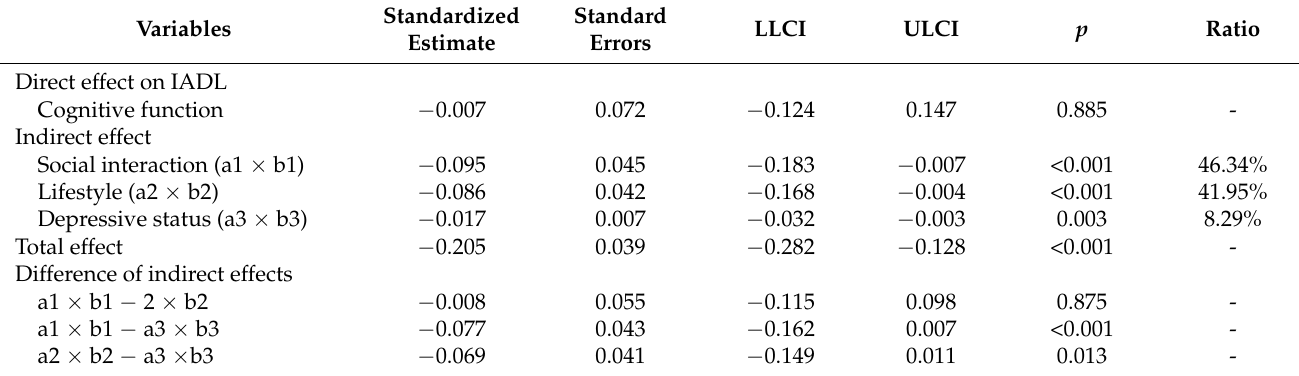
Table 2. Mediators in the longitudinal association between cognitive function and the severity of IADL